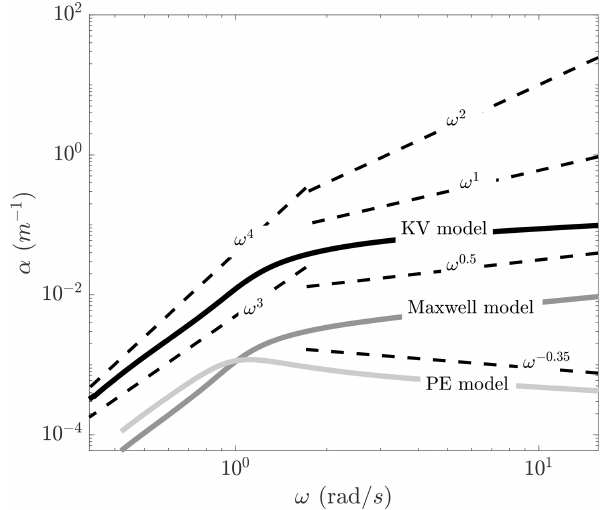
Figure 4. Log–log plots of α vs. ω curves constructed using differ- ent models. Curves are constructed by setting shear modulus to be